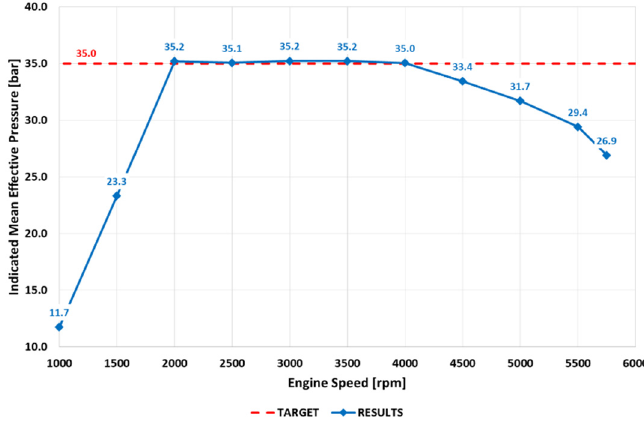
Figure 7. The predicted engine IMEP.